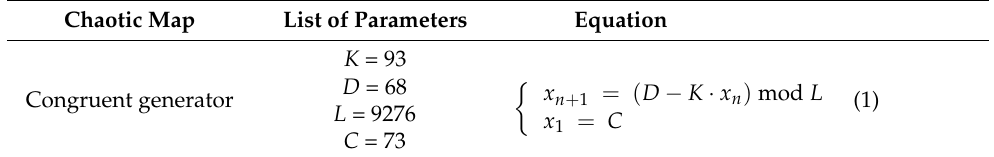
Table 2. Chaotic map equation and list of parameters with limits. Chaotic Map List of